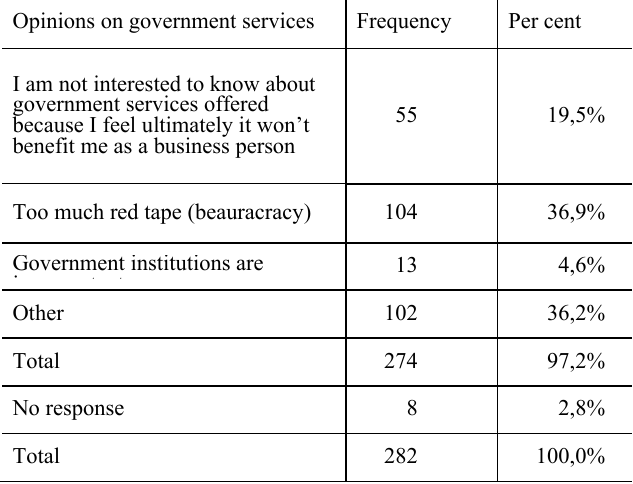
Table 9 documents the ratings of the respondents on the services provided by the government incentives. From Table 9, the majority of the respondents opted for the option “neither poor nor well” (fence